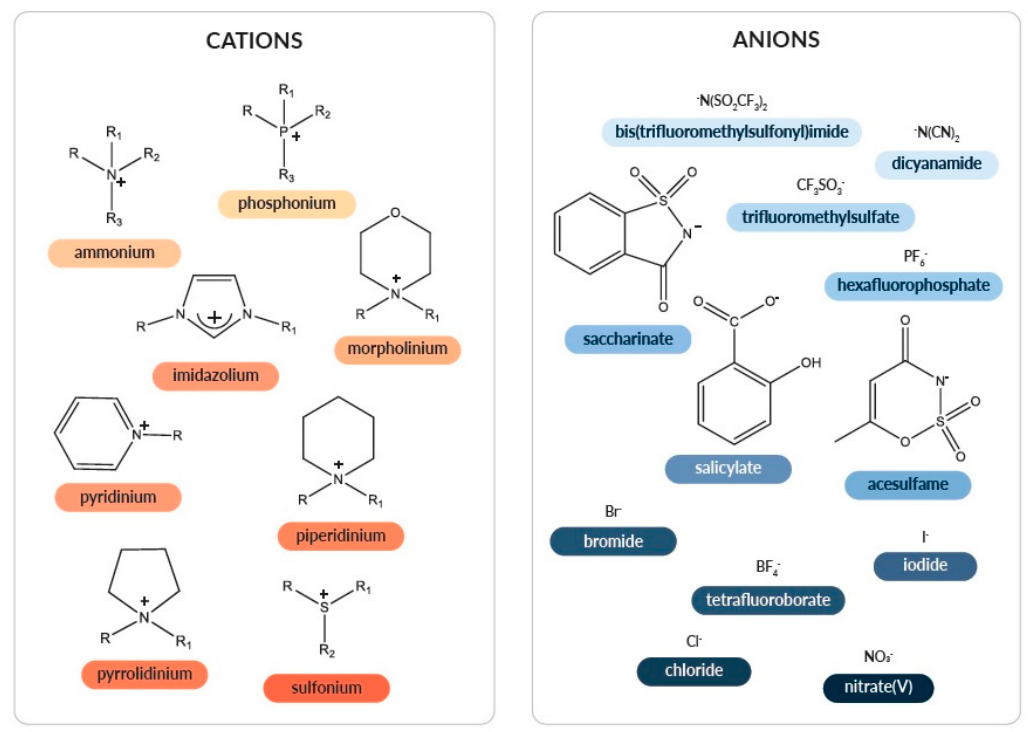
Figure 2. Diagram of the division of ionic liquids due to the type of cation and anion. R, R 1 , R 2 , R 3 —mainly alkyl, aryl, hydroxyl groups and hydrogen atoms.